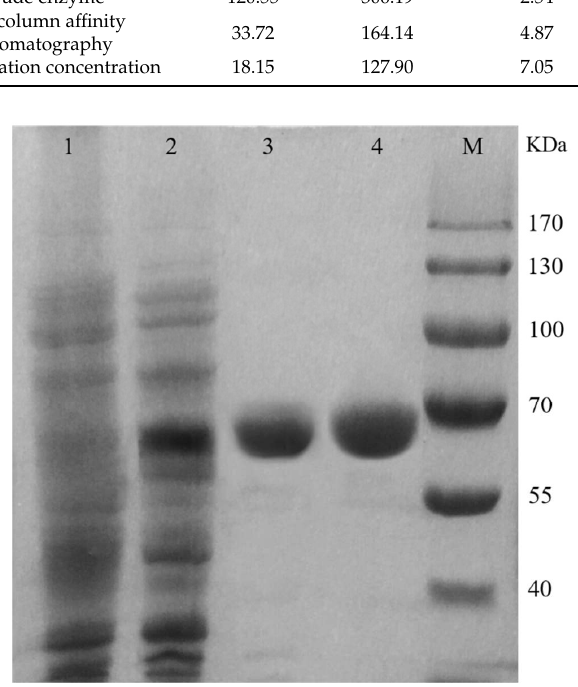
Figure 2. SDS-PAGE electrophoresis map of PanD purification Lane M, Protein Marker; Lane 1, empty control of E.coli BL21 / pET28; Lane 2, crude enzyme; Lane 3, the sample of purified mutant TcPanD-R98H / K305; Lane 4, the sample of the purified wild enzyme TcPanD (approximate molecular weight 65 kDa).